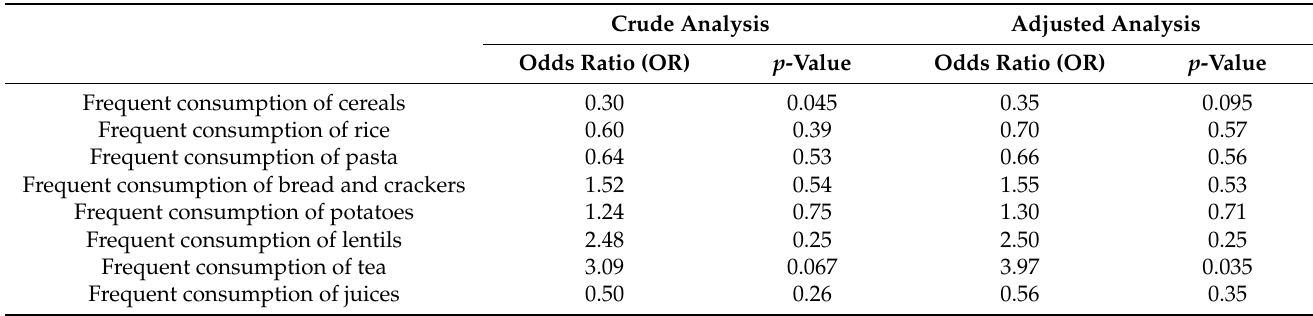
Table 3. Crude and adjusted 1 results from the analysis of associations of qualitative food frequency data with